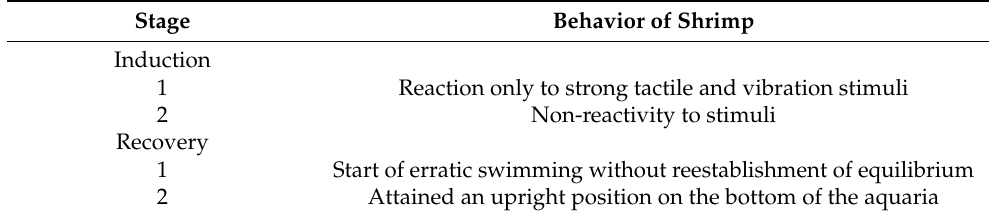
Table 1. Stages of anesthesia in shrimp according to Li et al. [21] (License number 5405151104023). Stage Behavior of Shrimp Induction Reaction only to strong tactile and vibration stimuli Non-reactivity to